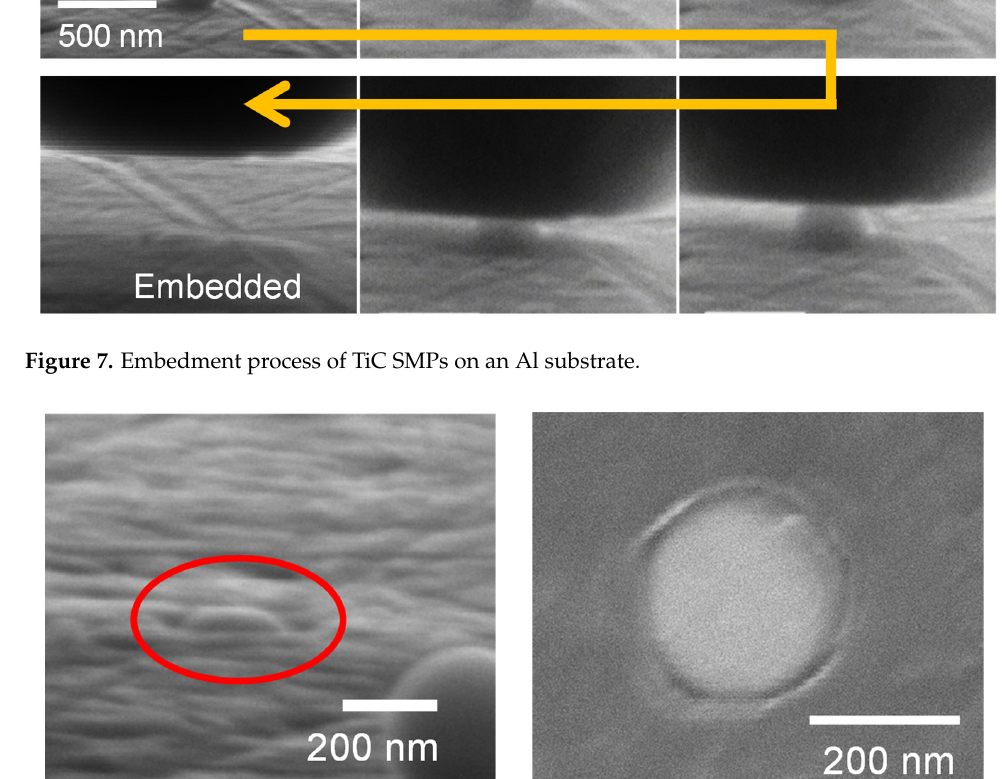
Figure 8. SEM images of the TiC ‐ SMP embedded region on an Al substrate: left: oblique downward view; right: top view.